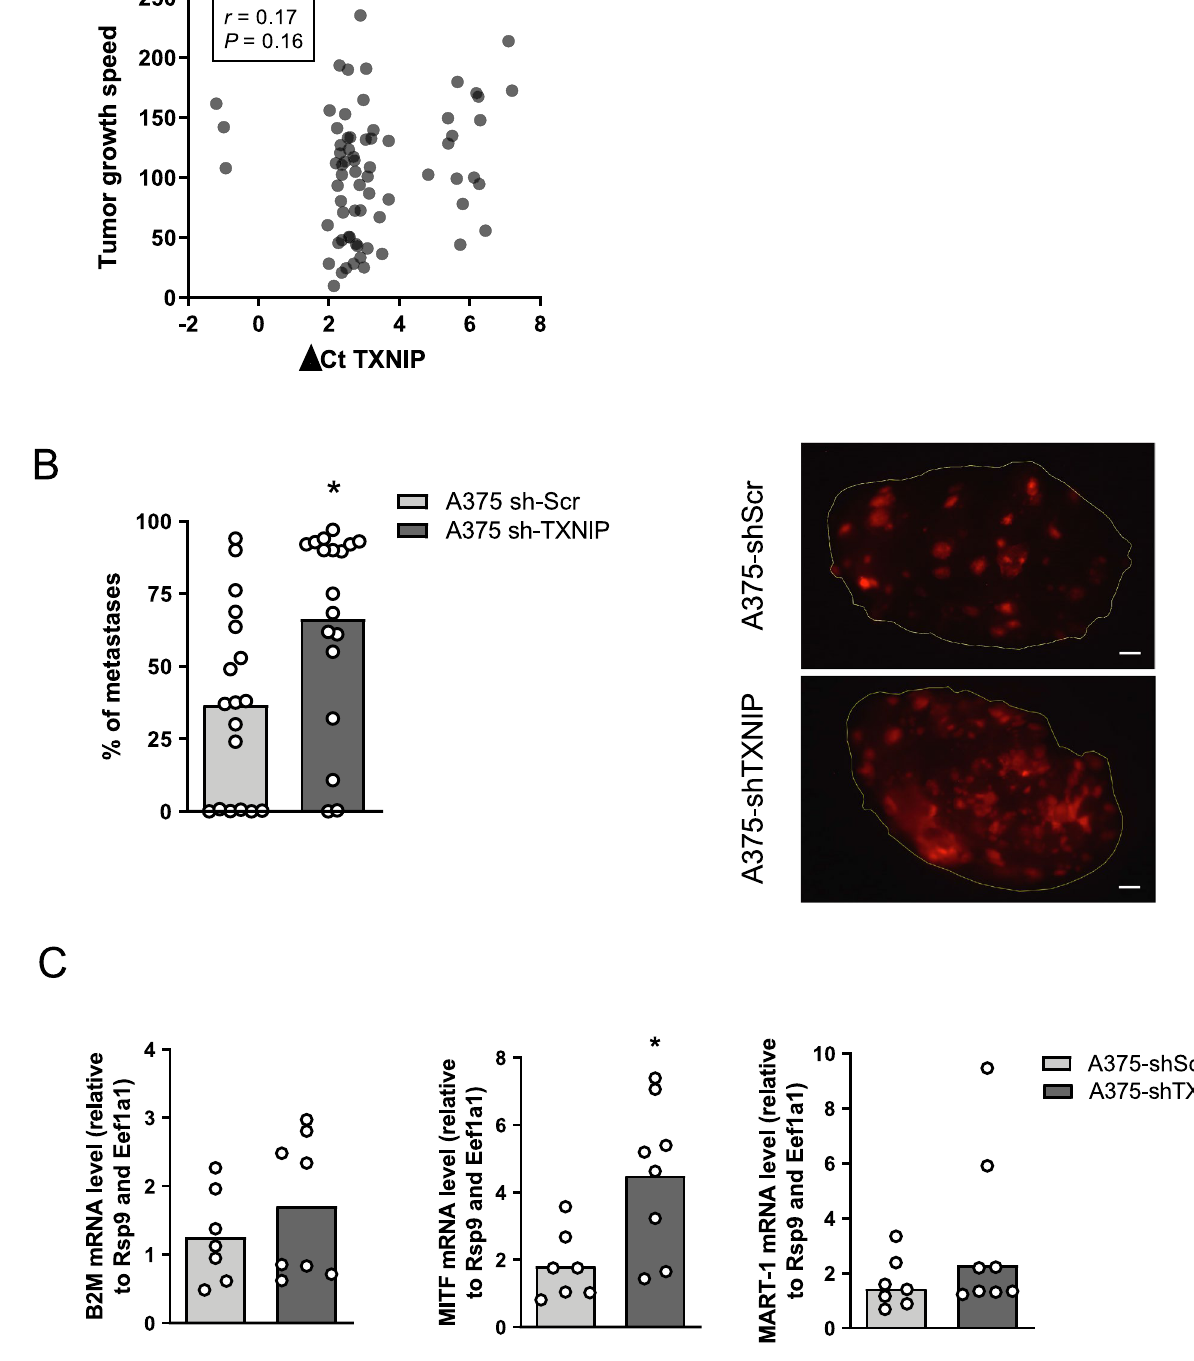
Figure 6. TXNIP silencing favors experimental human melanoma cell seeding into the lung. (A) Pearson correlation plot of subcutaneous tumor growth speed (mm 3 per day) and TXNIP mRNA expression in the tumor at the time of tumor collection. Each circle represents one individual tumor. (B) Left panel: Whole mount lung quantification of tumors three weeks after intravenous injection of mCherry-labeled A375-shScr or A375- shTXNIP cells in NSG mice. Each circle represents one individual mouse. Columns are means of individual samples (N = 18 mice per group). Statistics: unpaired Student’s t-test. Right panel: Representative pictures of lung surfaces collected three weeks after intravenous injection of mCherry-labeled A375-shScr or A375-shTXNIP in NSG mice (N = 18 mice per group). Scale bar: 1 mm. (C) RT-qPCR analysis of mRNA relative expression of the human genes B2M, MITF and MART-1 over the murine house-keeping genes Rsp9 and Eef1a1 in lungs collected 3 weeks after intravenous injection of mCherry-labeled A375-shScr or A375-shTXNIP cells in NSG mice. Each open circle represents one individual mouse (N = 7 A375-shScr mice; N = 8 A375-shTXNIP mice). Columns represent means of individual samples. Statistics: unpaired Student’s t-test. All panels *, P <